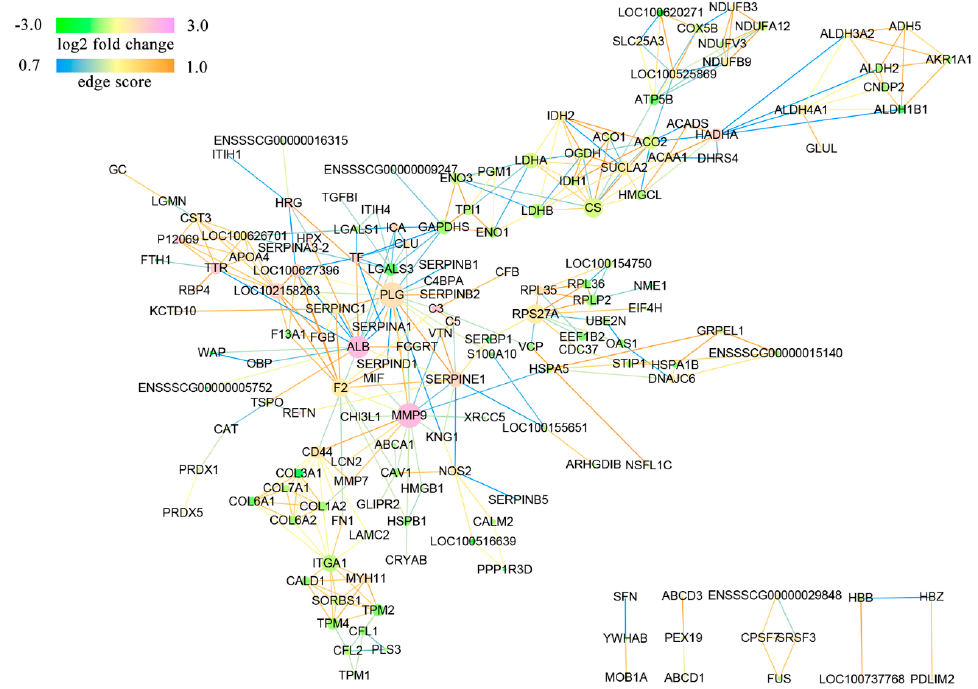
Figure 4. The protein–protein interaction networks of the DAPs were built using STRING 10.5 with a combined score larger than 0.7 (high confidence) and visualized with Cytoscape 3.4.0. DAPs are represented by round nodes. The pink node indicates up-regulation and the green node indicates down-regulation of the DAPs. The node size indicates high interaction degree (large) or low interaction degree (small). Proteins are connected with each other by an edge, which color indicates the combined score.